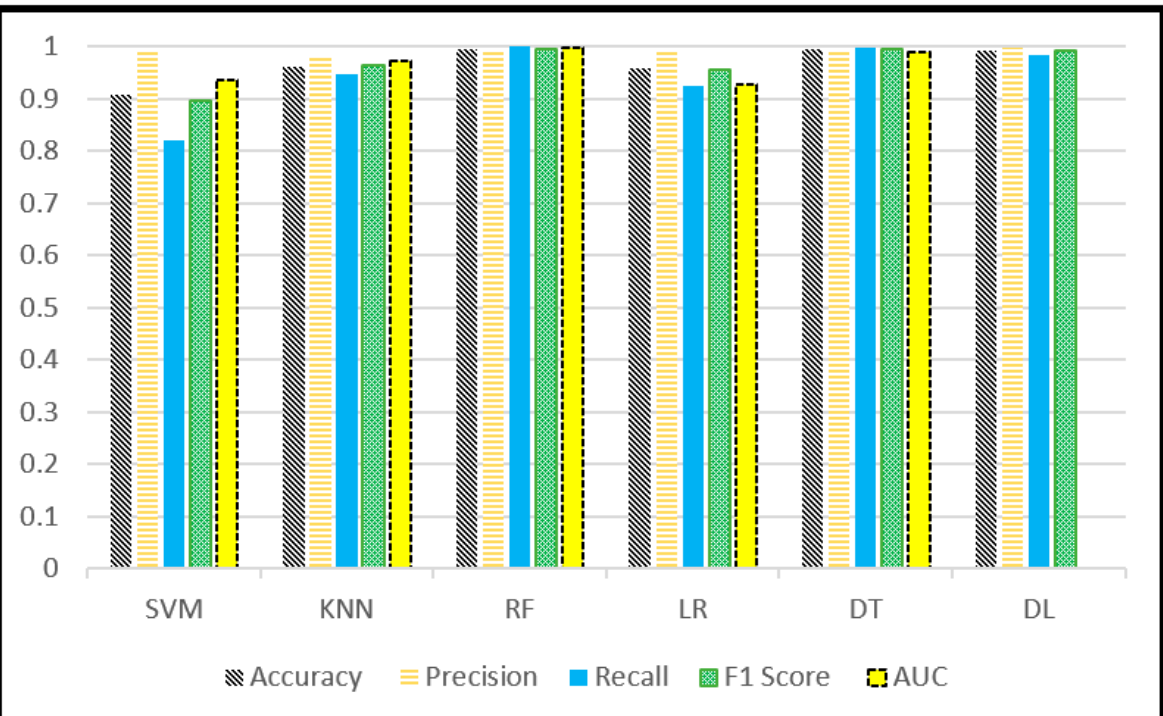
Figure 6. Comparison among the selected models of all criteria (data 2009–2013 and 2018–2022). From Figure 5, the RF achieved the highest accuracy, “99%”, and a maximum precision of “1”. This means the margin of error is zero, and the probability of classified threat